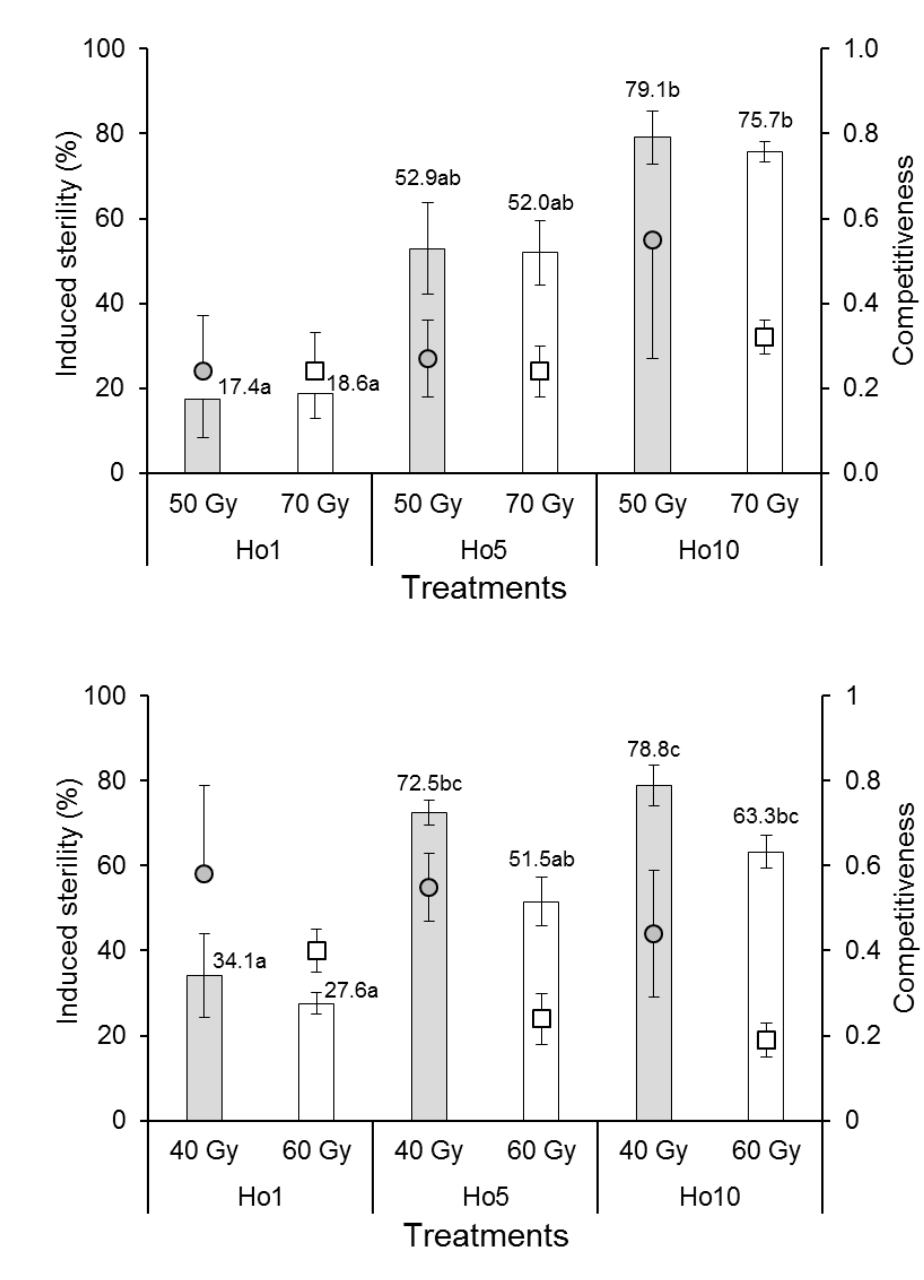
Figure 2. Mean male sexual competitiveness index values (circular and square points) and mean percentage induced sterility of eggs (columns) for ( A ) Aedes aegypti and ( B ) Aedes albopictus females that mated in laboratory cages with males that had been exposed to one of two doses of radiation in the pupal stage. Controls included only fertile males (Hn) and only irradiated males (Hs). Values above columns indicate mean percentages of egg sterility. Means followed by identical letters did not differ significantly for comparisons among mating treatments and doses (ANOVA, Tukey p > 0.05). Vertical bars indicate the standard error. For clarity, only half the error bar is shown in some cases.